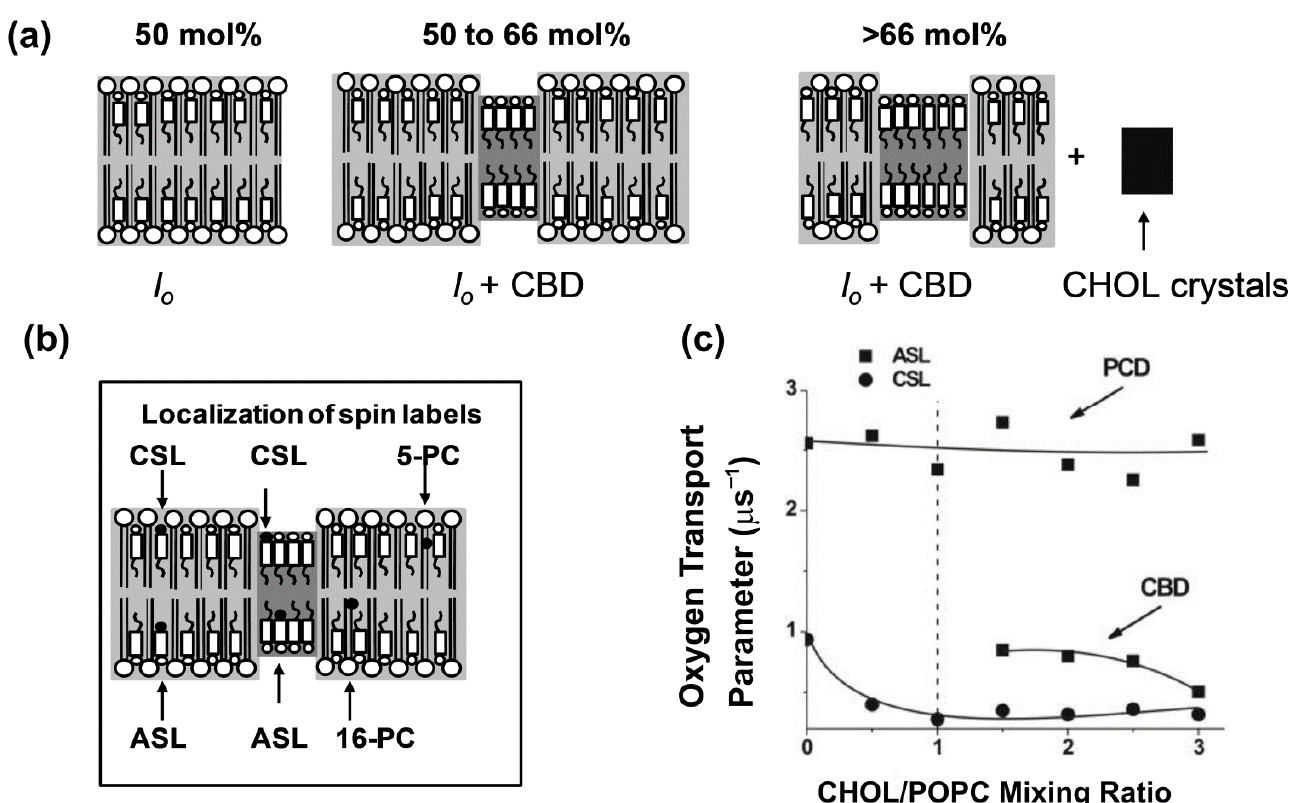
Figure 6. Schematic drawings and experimental data are for Chol/POPC membranes formed using the film deposition method [73]. ( a ) Schematic drawings of different membrane structures that can form at Chol contents exceeding the Chol saturation limit in the POPC bilayer (50 mol%). At the Chol saturation limit, the POPC bilayer forms the l o phase. When the Chol content exceeds the 50 mol% limit, pure CBDs are formed (indicated in grey), and between 50 and 66 mol% Chol (Chol solubility threshold), CBDs are supported by the POPC bilayer saturated with Chol forming one structured l o phase of the POPC bilayer. The phase boundary at 66 mol% Chol separates the structured l o phase region from the two-phase region (structured l o phase of POPC and Chol crystals). ( b ) Localization of representative phospholipid spin labels (5-PC and 16-PC) as well as Chol-analog spin labels (ASL and CSL) in different membrane domains are indicated. ( c ) The values of the OTP accessibility parameter obtained with ASL and CSL in POPC-Chol bilayers are displayed as a function of the Chol/POPC mixing ratio. Note that above the Chol saturation limit (at a Chol/POPC mixing ratio of 1), ASL discriminates two domains with two different OTPs assigned to the POPC bilayer saturated with Chol and to CBD. However, CSL shows only a single value of the OTP at all investigated Chol contents. ( c ) is reproduced from [71]. Copyright 2022, with permission from Elsevier.